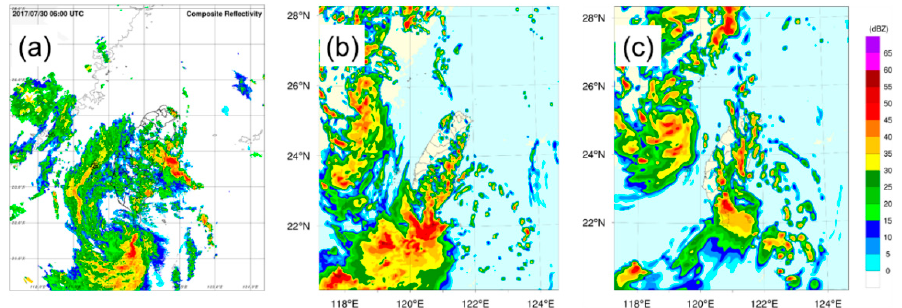
Figure 11. Same as in Figure 9 ( a – c ), but for TC Haitang at 30-h forecast (valid for 0600 UTC 30 July 2017).